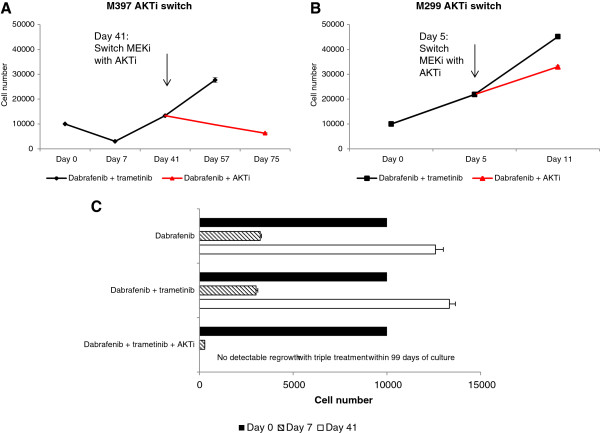
Addition of AKTi upon development of resistance to MAPK inhibitors can provide further growth inhibition in long term culture, while triple treatment from the beginning delays the emergence of resistance. The PTEN -/- cell line M397 (A) and M299 (B) were cultured in 96-well plates in the presence of 200 nM dabrafenib in combination with 2 nM trametinib. On day 41 or day 5 trametinib was replaced with AKTi (indicated by the arrow in the two cell lines respectively). (C) From day 0, M397 was cultured in the presence of 200 nM dabrafenib alone or in combination with 2 nM trametinib or in the presence of triple drugs; 200 nM dabrafenib, 2 nM trametinib and 2.5 uM AKTi. Cell numbers were determined by a MTS-based assay and use of a gradient with known number of cells which allowed the readout of each well to be calculated into a quantitative cell count (Additional file 5: Figure S5). The cell number for each time point represents the average cell number in 60 well replicates for the plates treated with dabrafenib and trametinib, and 120 replicate wells for the AKTi switch plates.